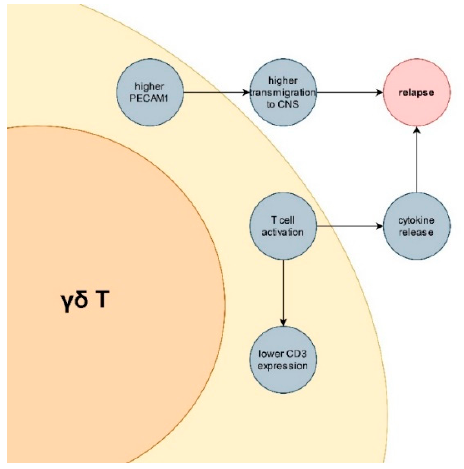
Figure 6. Summary of major findings and their theoretical implications for multiple sclerosis immunopathogenesis.